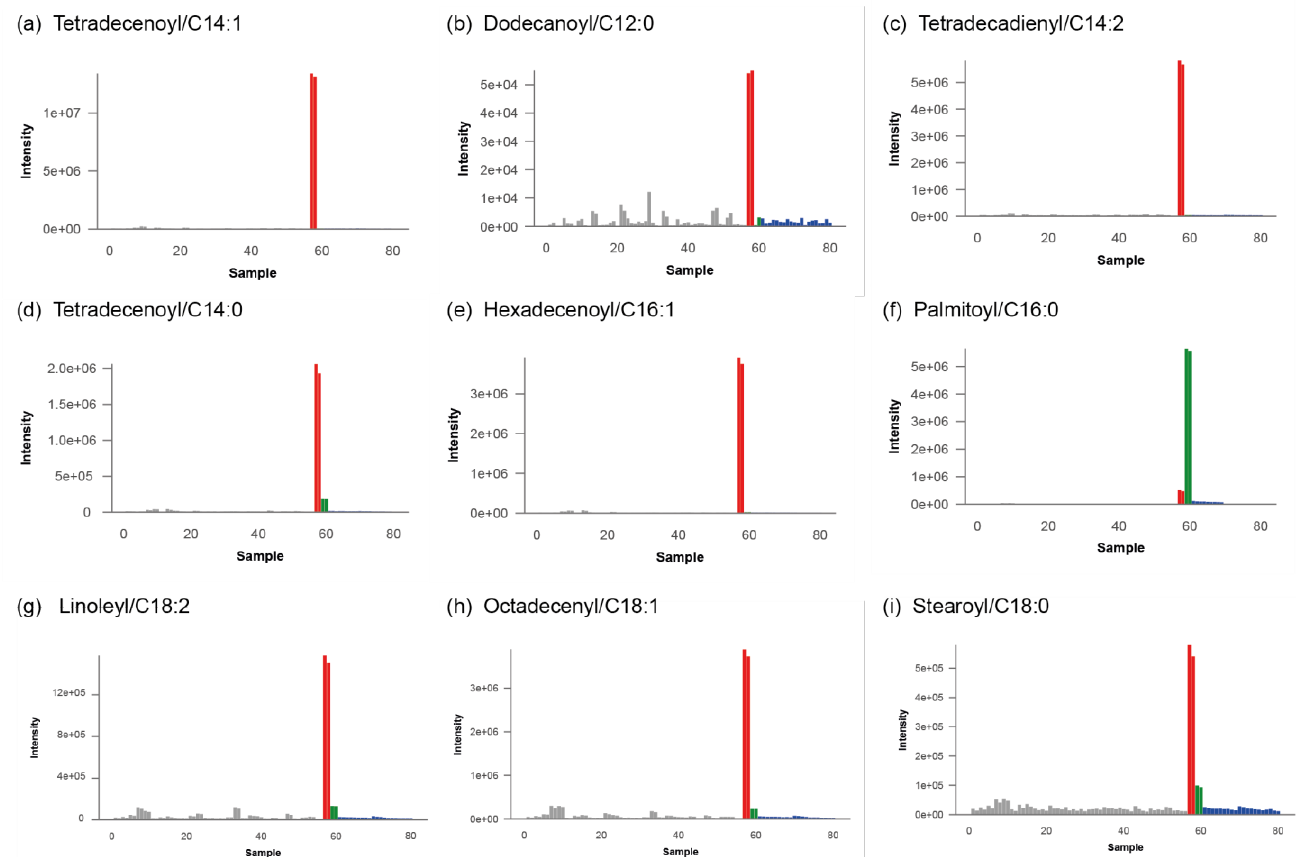
Figure 6. Bar plots for diagnostically relevant mass features corresponding to carnitine ester species of long-chain fatty acids. Patient is shown in red, other patients measured this analytical run in grey, plasma QC pools are shown in blue and validation plasma samples are displayed in green.